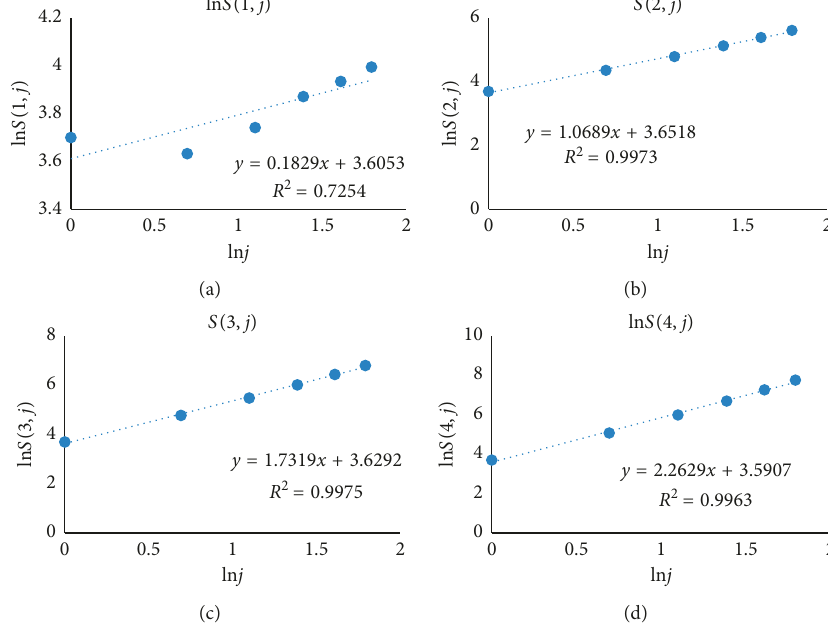
y = 0.1829 x + 3.6053